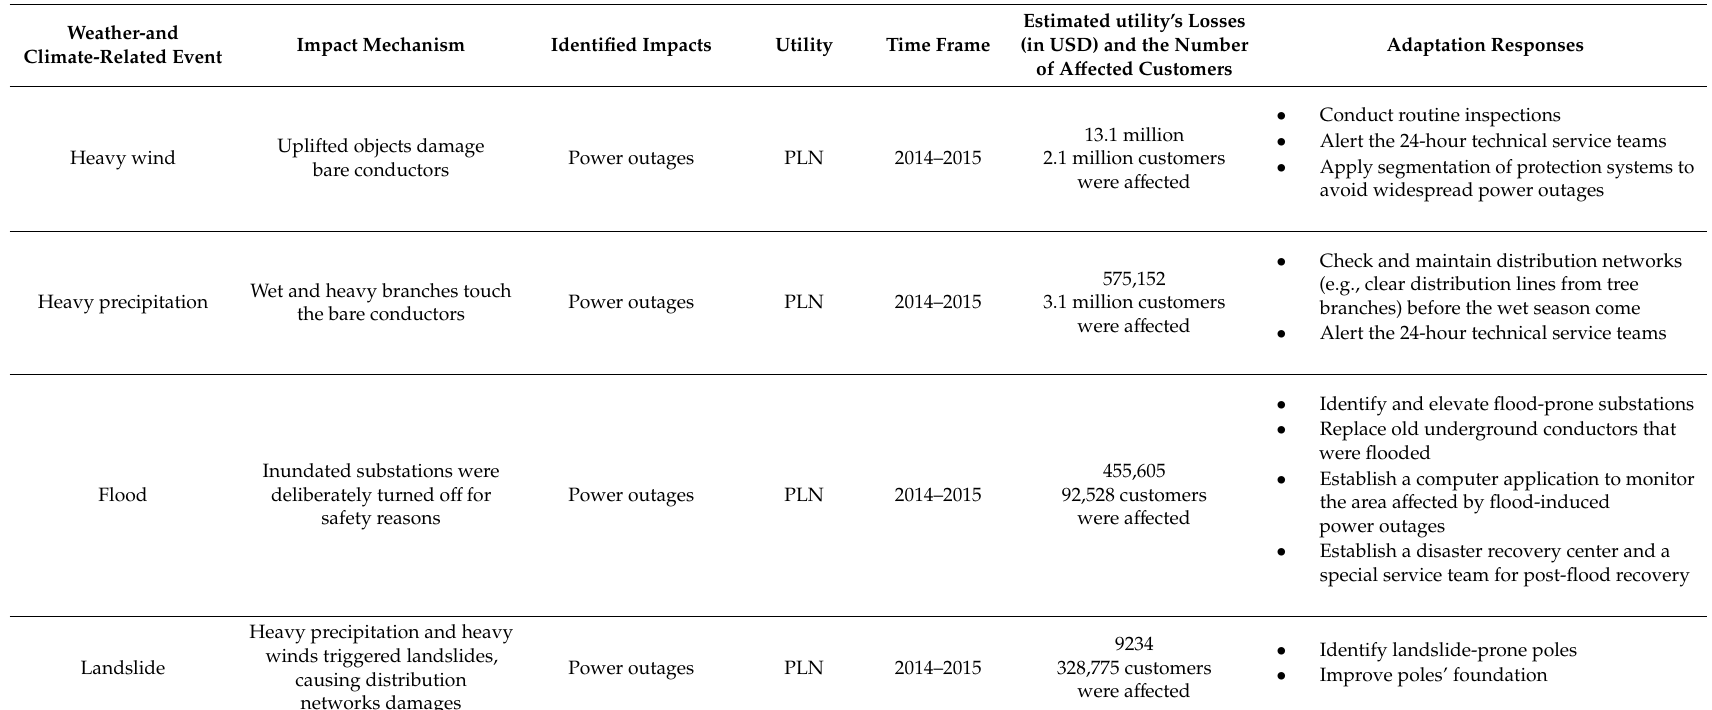
Table 6. Impacts of severe weather events on distribution networks and the utility’s autonomous adaptation responses. Source: own